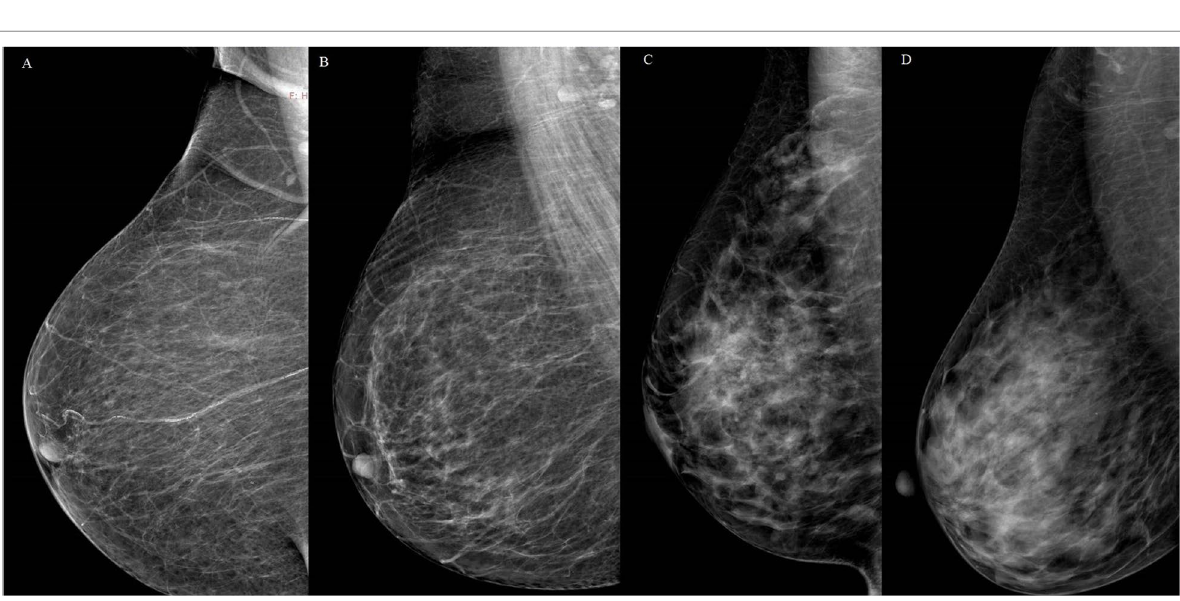
Fig. 2 Medio-lateral oblique views of mammograms of different patients showing ACR BI-RADS categories ( A , B , C and D ) of breast